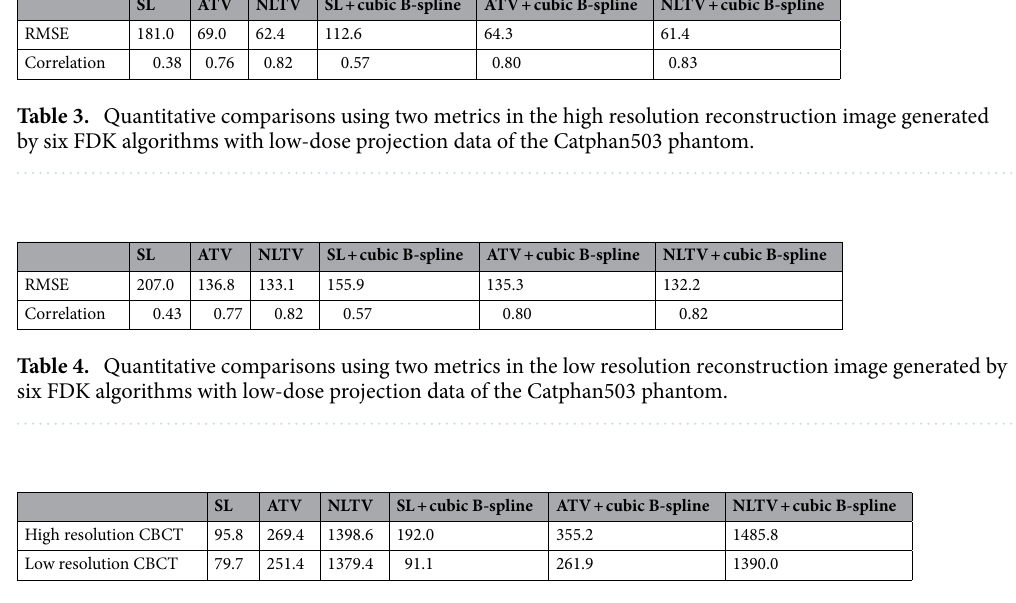
Table 5. Computation time (seconds) of six FDK algorithms when creating high resolution and low resolution CBCTs of the Catphan503 phantom.